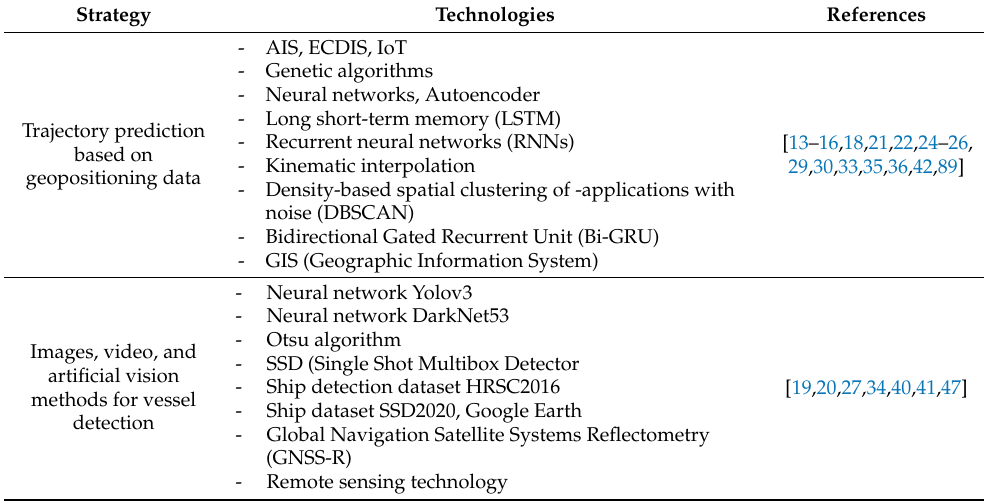
Table 5. Strategies detected in papers reviewed to deal with traffic monitoring problems.